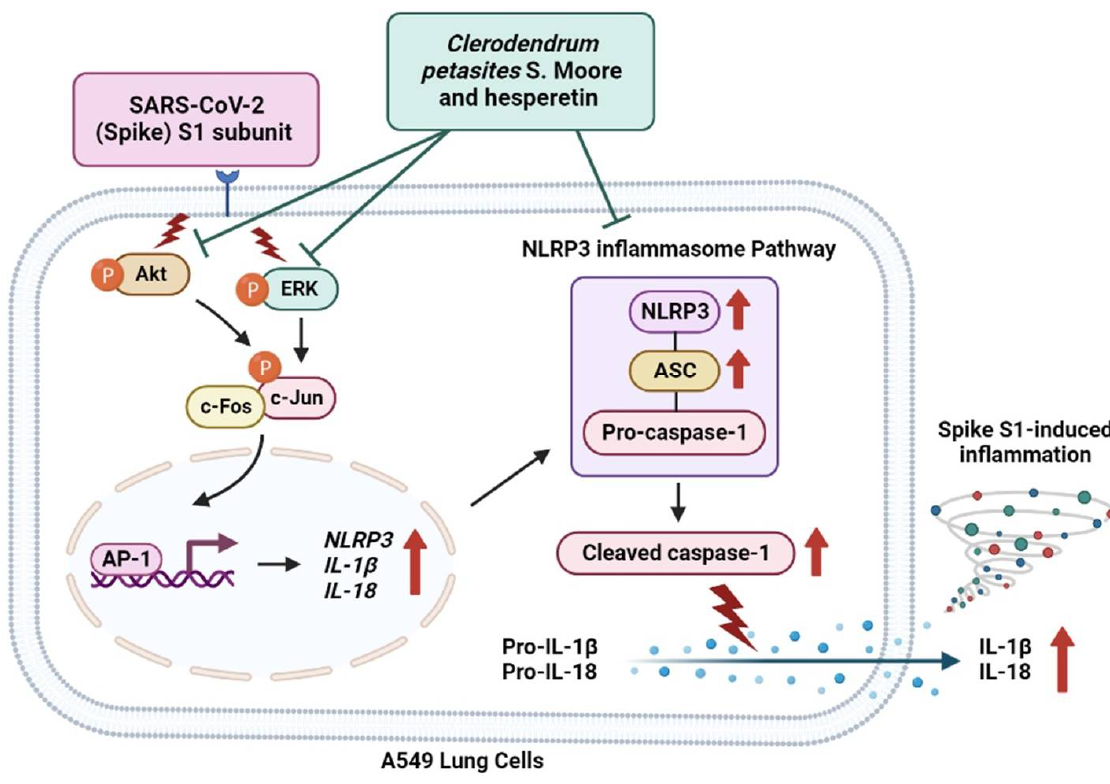
Figure 7. Schematic concluding mechanism of hesperetin-enriched fraction from Clerodendrum petasites S. Moore (CpEA) and hesperetin-attenuated Spike S1-induced NLRP3 inflammasome inflammation through the inactivating of Akt/Erk/c-Jun signaling pathway in A549 cells.